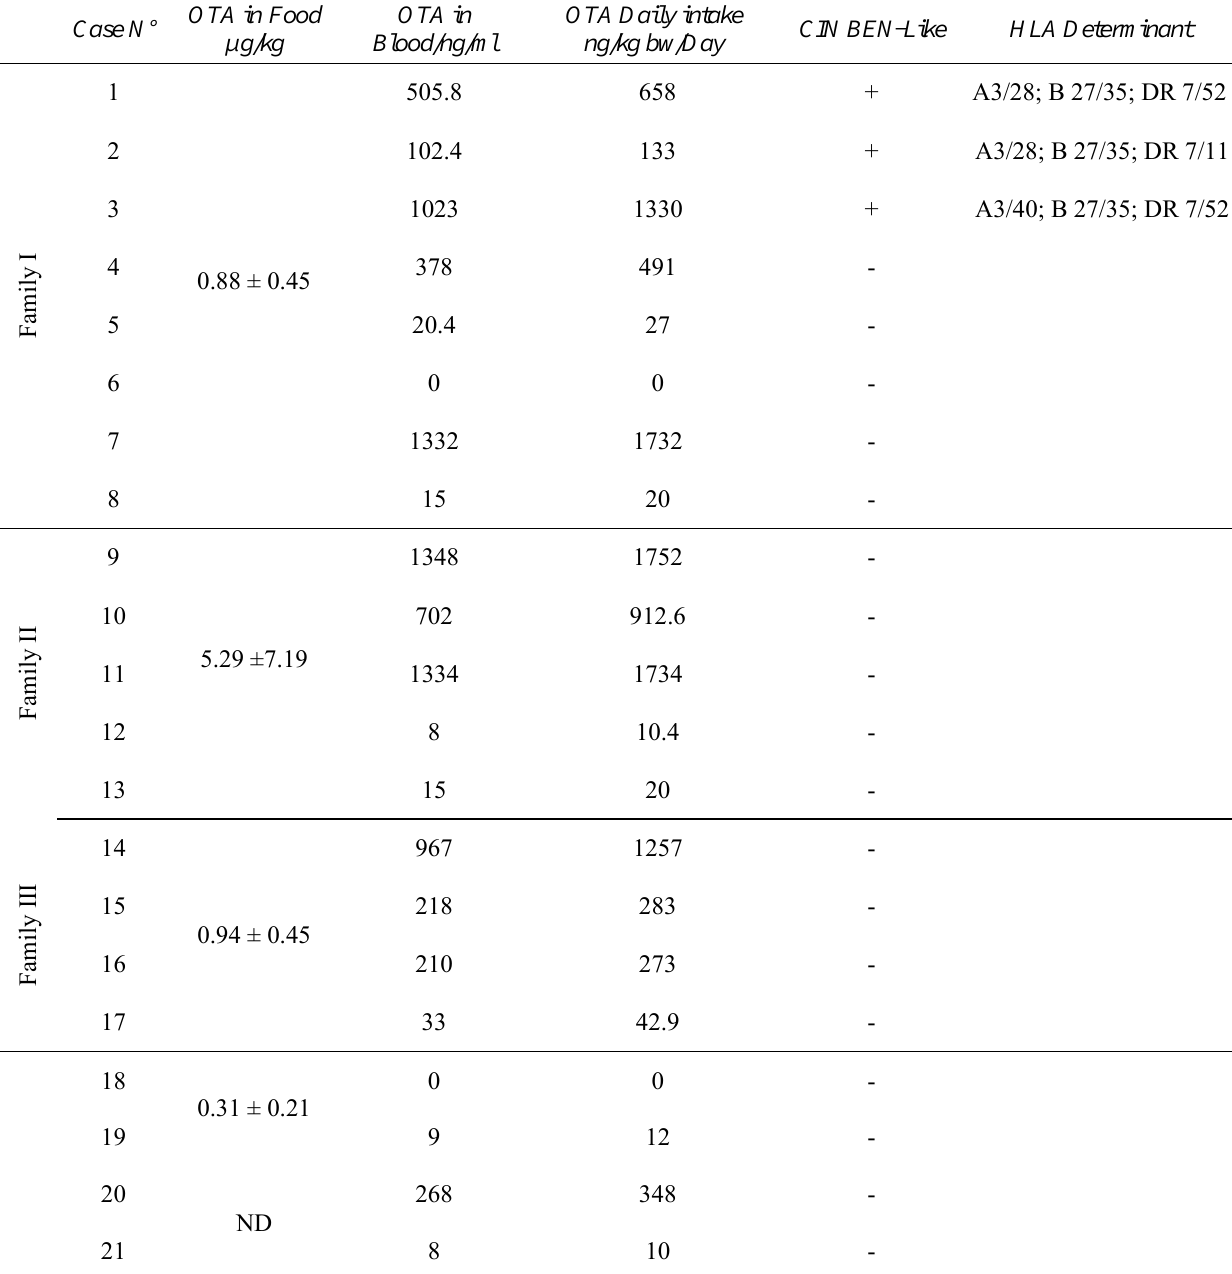
Table 2: HLA haplotype of patients CIN BEN-like and daily intake of OTA for the subjects calculated from the plasma clearance, blood concentration and bioavailability of OTA in human according to the following equation, K= Cpl x Cp/A in which K= daily intake, Cpl= OTA plasma clearance ml/min, Cp=OTA plasma concentration and A=